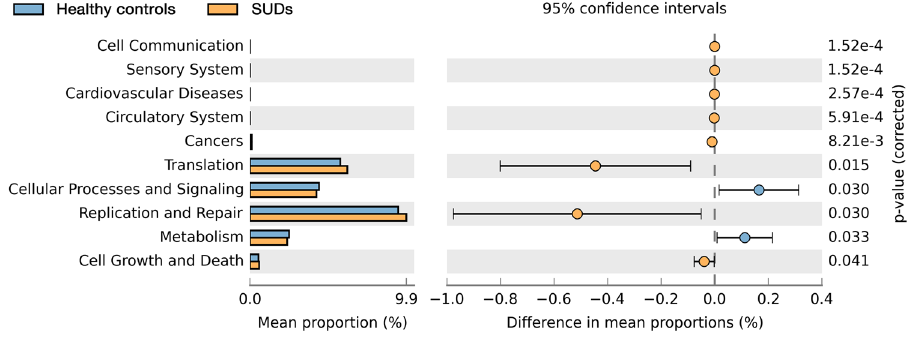
Figure 6. Compare the difference notability function in KEGG module prediction using 16S data with